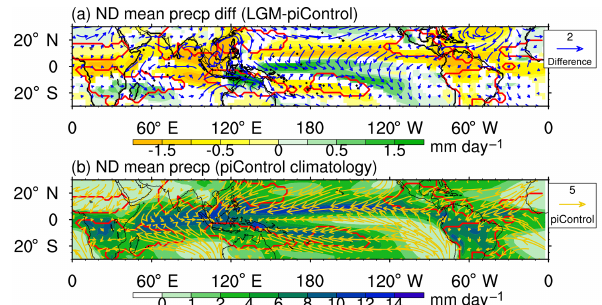
Figure 6. (a) ND mean precipitation (shading) difference and sur- face wind (vectors) difference between LGME and piControl, and (b) the climatology of ND mean precipitation (shading) and surface wind (vectors) derived from piControl. The red lines enclose the monsoon domains. The thick black lines in (a) denote the coastal lines in LGME provided by CMIP5–PMIP3, and the thin black lines denote the coastal lines in piControl. Only those areas where the signal-to-noise ratio exceeds 1 are plotted in (a)